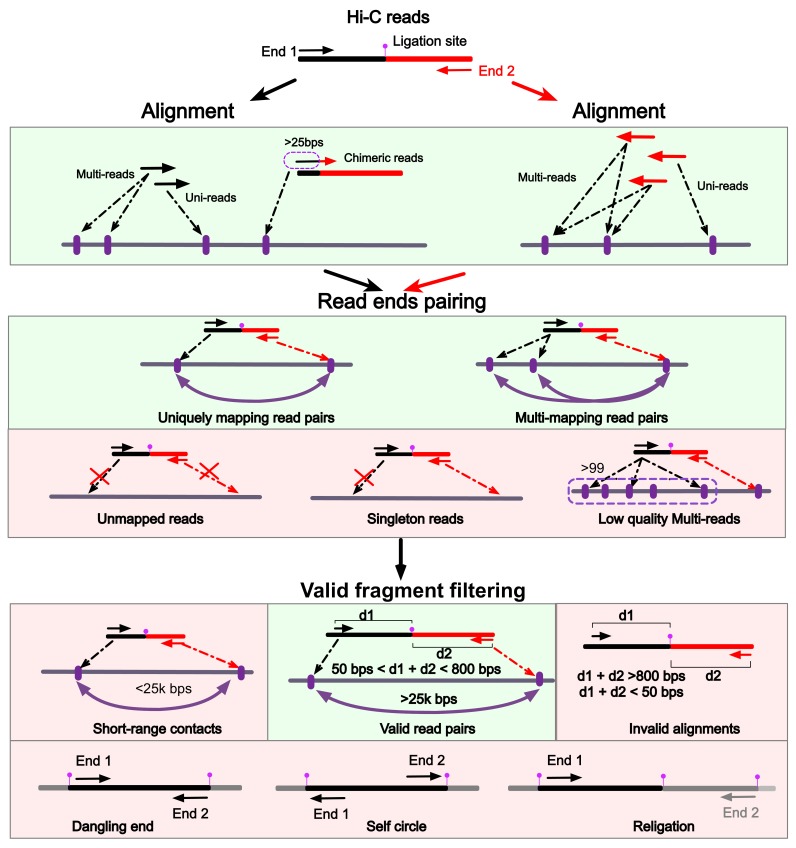
mHi-C pipeline (Alignment - Read end pairing - Valid fragment filtering).1. Read ends are aligned to reference genome separately allowing multi-reads and chimeric reads to be rescued. 2. Read ends are paired by their read query names. Multi-reads form more than one read pair with the same read query name. Read ends that fail to align form either unmapped reads or singleton reads and are discarded. Multi-reads with ends aligning to more than 99 positions are regarded as low-quality multi-reads and are excluded from the downstream analysis. 3. Validation checking to filter short-range contacts and alignments far away from restriction enzyme recognition sites. Contacts residing within the same restriction fragment, that is dangling end or self-circle, as well as adjacent fragments (religation) are discarded. The above three processing steps are applied to each read independently enabling parallel implementation.